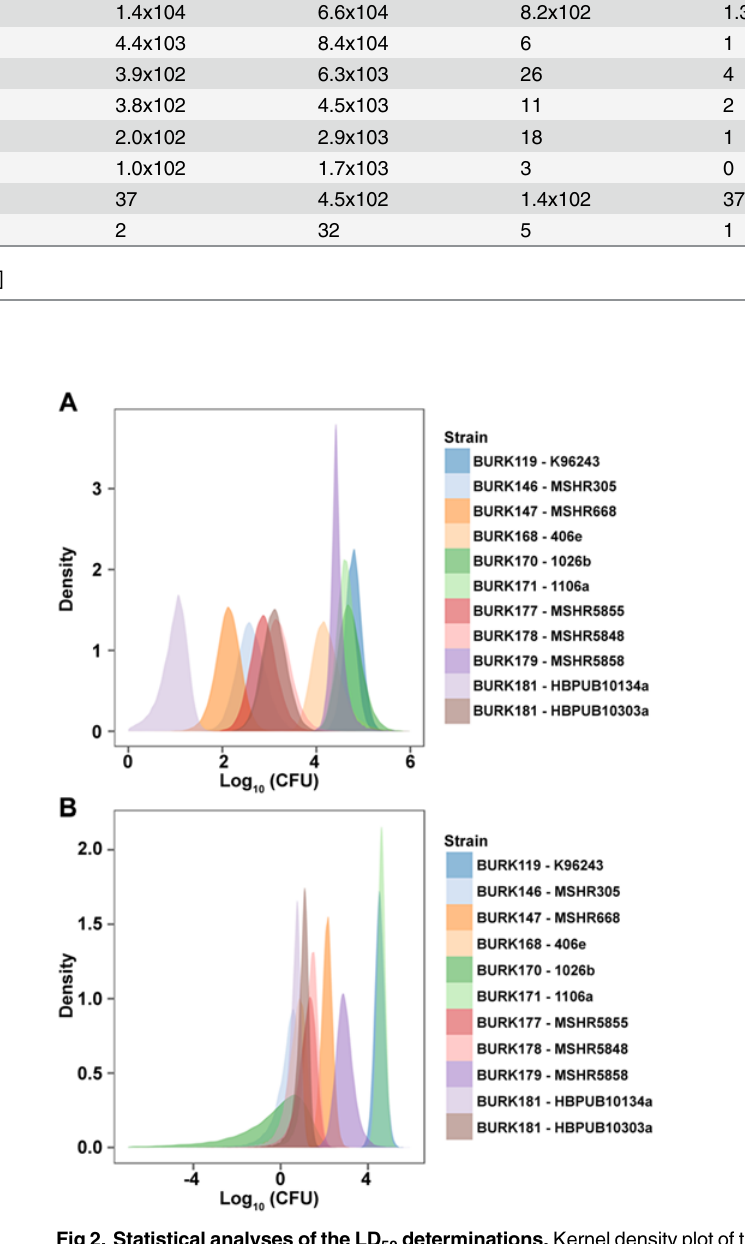
Fig 2. Statistical analyses of the LD 50 determinations. Kernel density plot of the posterior distributions of the